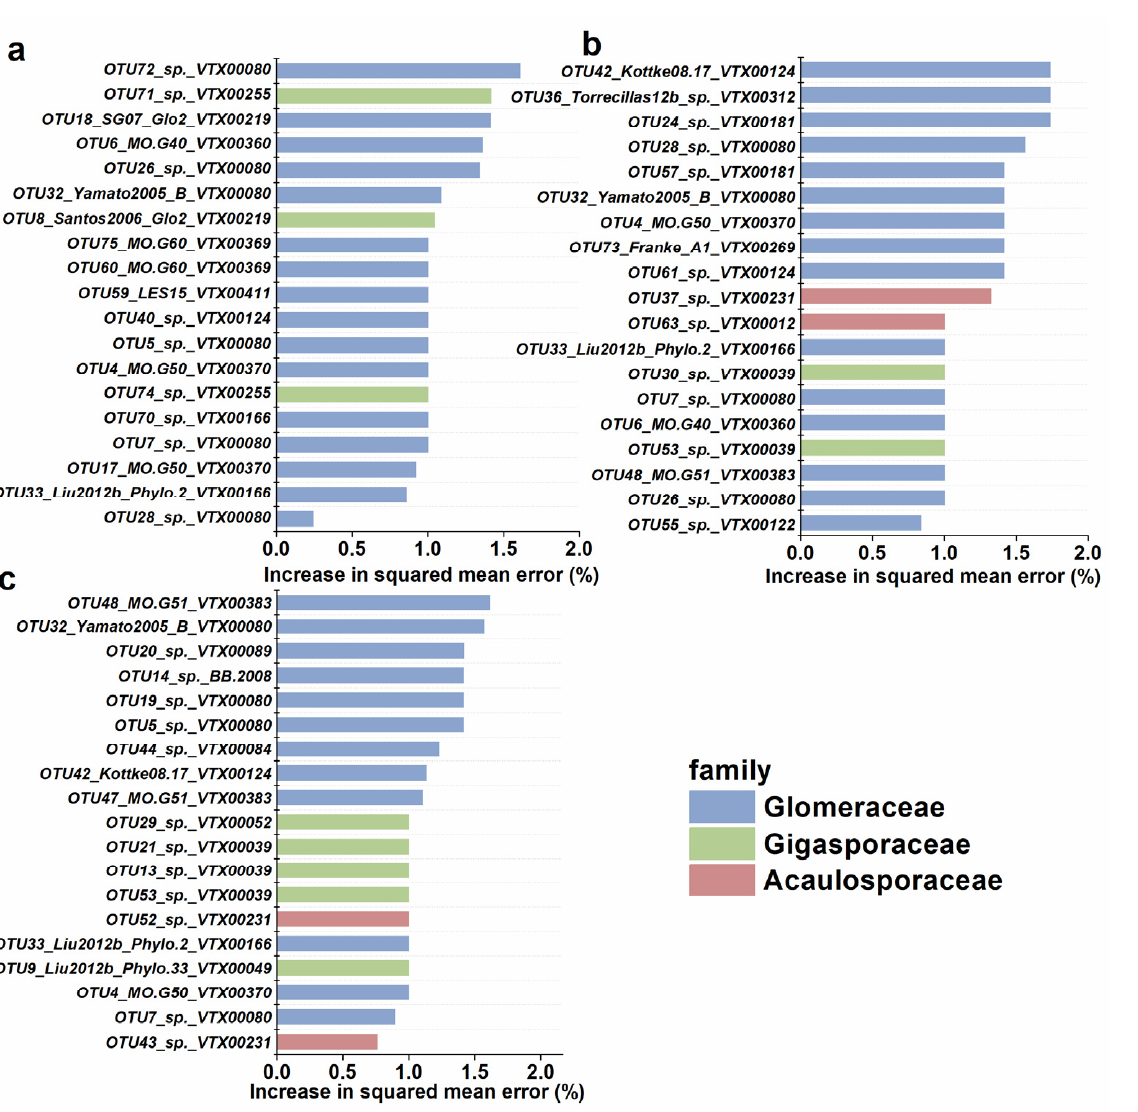
Figure 6. Predictor importance (Percentages of increase in mean square error (MSE) between obser- vations and OOB predications) of the top AM fungal taxonomic biomarkers in young plantation ( a ), middle plantation ( b ) and mature plantation ( c ).